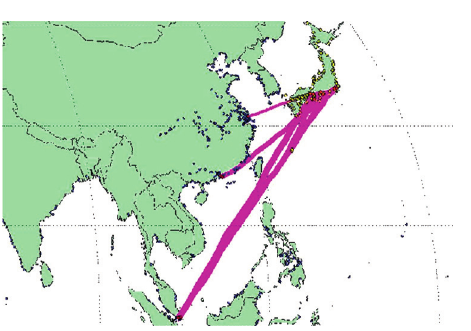
Figure 8: Primary flows between the Japanese ports and the world.